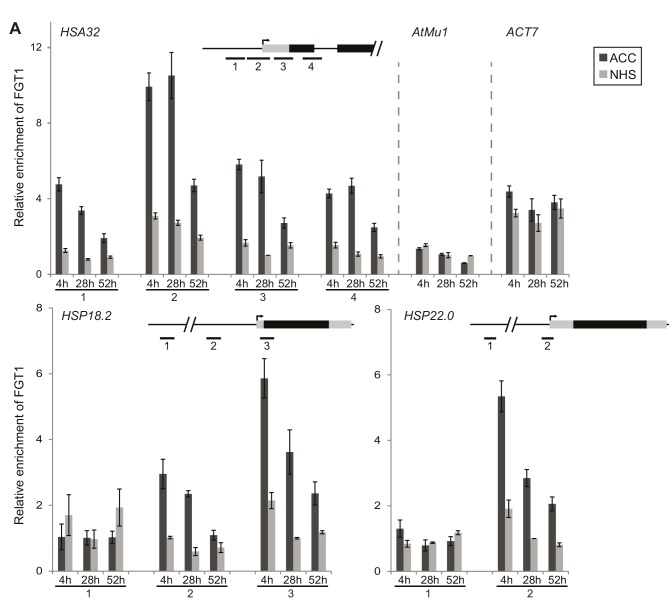
FGT1 binds memory-associated genes in a HS-dependent manner.FGT1 binds to HSA32, HSP18.2 and HSP22.0. ChIP-qPCR on 35S::FGT1-YFP seedlings was performed 4, 28 or 52 h after an acclimatizing HS (ACC) or no HS (NHS). As controls, the active gene ACT7 or the inactive transposon AtMu1 were used. Schematics show regions analyzed relative to TSS. HSA32 1–4: −175, −75, +57, +194 bp. HSP18.2 1–3: −1068, −367, +32 bp. HSP22.0 1–2: −3000, −60 bp; ACT7: +55 bp. AtMu1: -175 bp relative to ATG. Amplification values were normalized to input and region 2HSA32 at 28 h NHS (HSA32, AtMu1 and ACT7), region 2HSP18.2 at 28 h NHS or region 3HSP22.0 at 28 h NHS, respectively. Data are averages of at least three biological replicates. Error bars indicate SE.